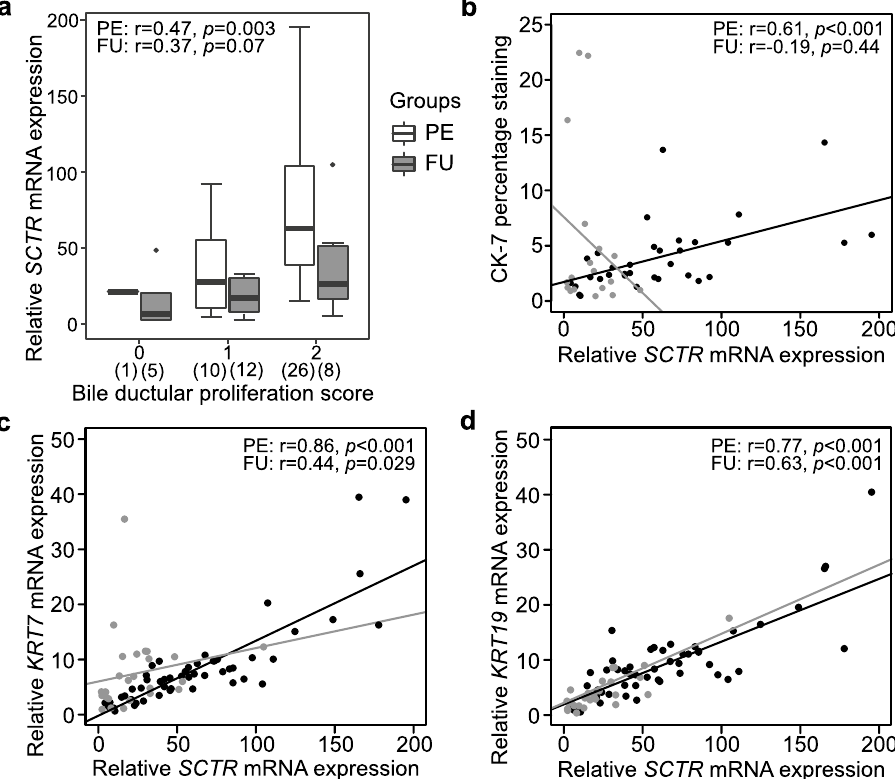
Figure 4. Correlations between liver secretin receptor ( SCTR ) mRNA expression and surrogates for ductular reaction. ( a ) Box plot (median, interquartile range and 90th percentile) of relative SCTR expression in biliary atresia patients at portoenterostomy (PE) and during follow-up (FU) according to CK-7 positive bile ductular score. Correlation between SCTR and ( b ) CK-7 percentage staining, ( c ) KRT7 and ( d ) KRT19 mRNA expression. Black dots represent samples obtained at PE and grey dots represent follow-up (FU) samples after successful